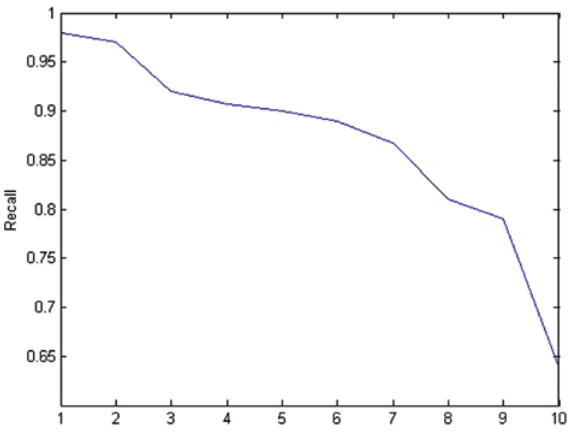
Figure 9: Evaluation of Recall.